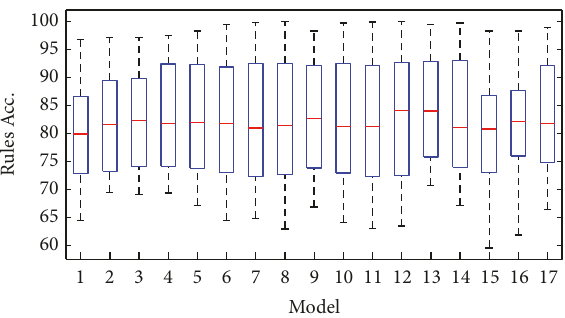
Figure 7: Boxplots of the average predictive accuracy of the extracted rulesets ( 𝑦 -axis) with respect to each model ( 𝑥 -axis).